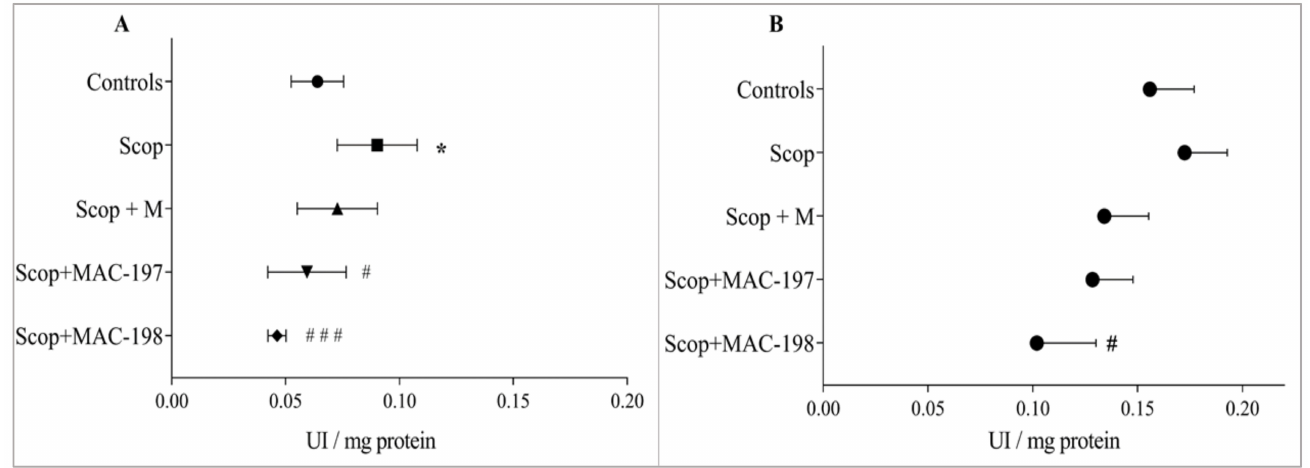
Figure 6. Effects of MAC-197 and MAC-198 on brain AChE activity in the cortex ( A ) and the hippocampus ( B ) in rats with scopolamine-induced dementia; M (40 mg/kg) was used as referent; UI—international units; data are expressed as the mean ± SEM ( n = 5). * p < 0.05 vs. Controls; # p < 0.05, # # # p < 0.001 vs. Scop group.